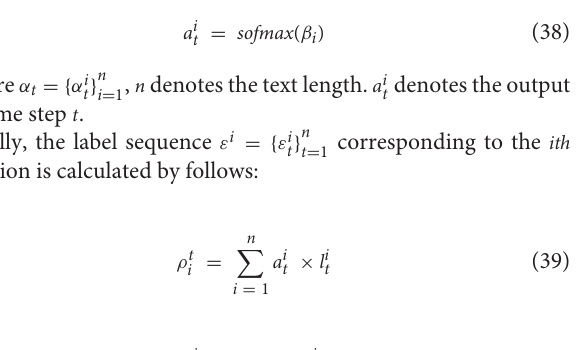
The best experiment results are denoted by the bold